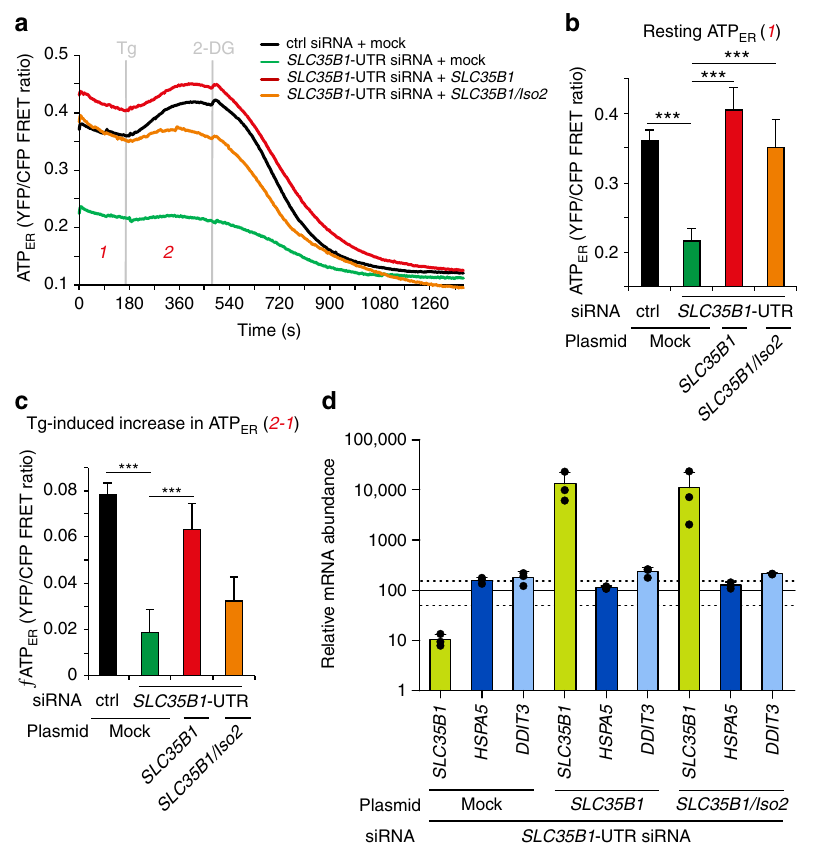
Fig. 7 SLC35B1 expression rescues ATP levels in the ER after SLC35B1 knockdown. a – c HeLa cells were transfected with control siRNA or with SLC35B1 -UTR- targeting siRNA plus SLC35B1 expression plasmids for 72 h. The cells were transfected with ERAT4.01. After 24 h, they were imaged by fl uorescence microscopy, and the FRET-ratio F 535 /F 480 was recorded in real-time. Where indicated, 1 µ M Tg or 10 mM 2-DG were added. a Time-resolved live cell recordings of ER luminal ATP levels. Data are presented as means of ctrl, n = 71 cells, UTR siRNA, n = 39, SLC rescue, n = 18, and Iso2 rescue, n = 13 from at least three independent experiments. b Quanti fi cation of resting ATP ER concentration in a . c Quanti fi cation of Tg-induced ATP ER concentration in a . Three time points before Tg addition were averaged (indicated as 1) and subtracted from the MAX-values (indicated as 2) following Tg addition for each single cell. Data in b and c are presented as mean with SEM. The indicated pairs were assessed by unpaired, two-sided standard Student´s t -test (* P < 0.05, ** P < 0.01, ** P < 0.001). d Mean quantitative RT-PCR values are shown after transfection of HeLa cells with control siRNA or with SLC35B1 -UTR targeting siRNA plus SLC35B1 expression plasmids. Data from three independent experiments are reported together with the individual data points as % of control with SEM. The light lines indicate the 50 and 150% values. The HSPA5 gene encodes BiP, the DDIT3 gene